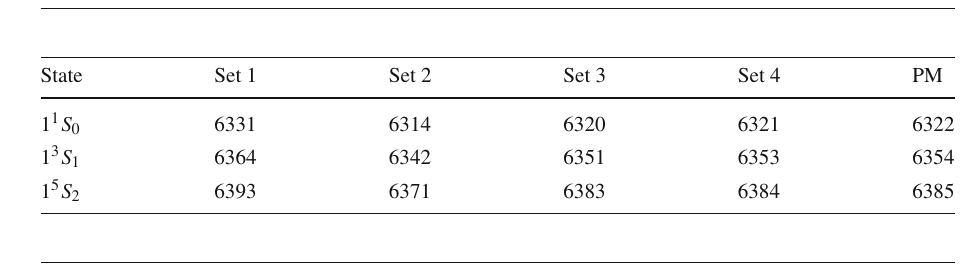
Table 12 Responses in bb ¯ b ¯ b tetraquark mass values to potential parameter input in group 1. PM stands for results of potential model used in this work. All results are in MeV